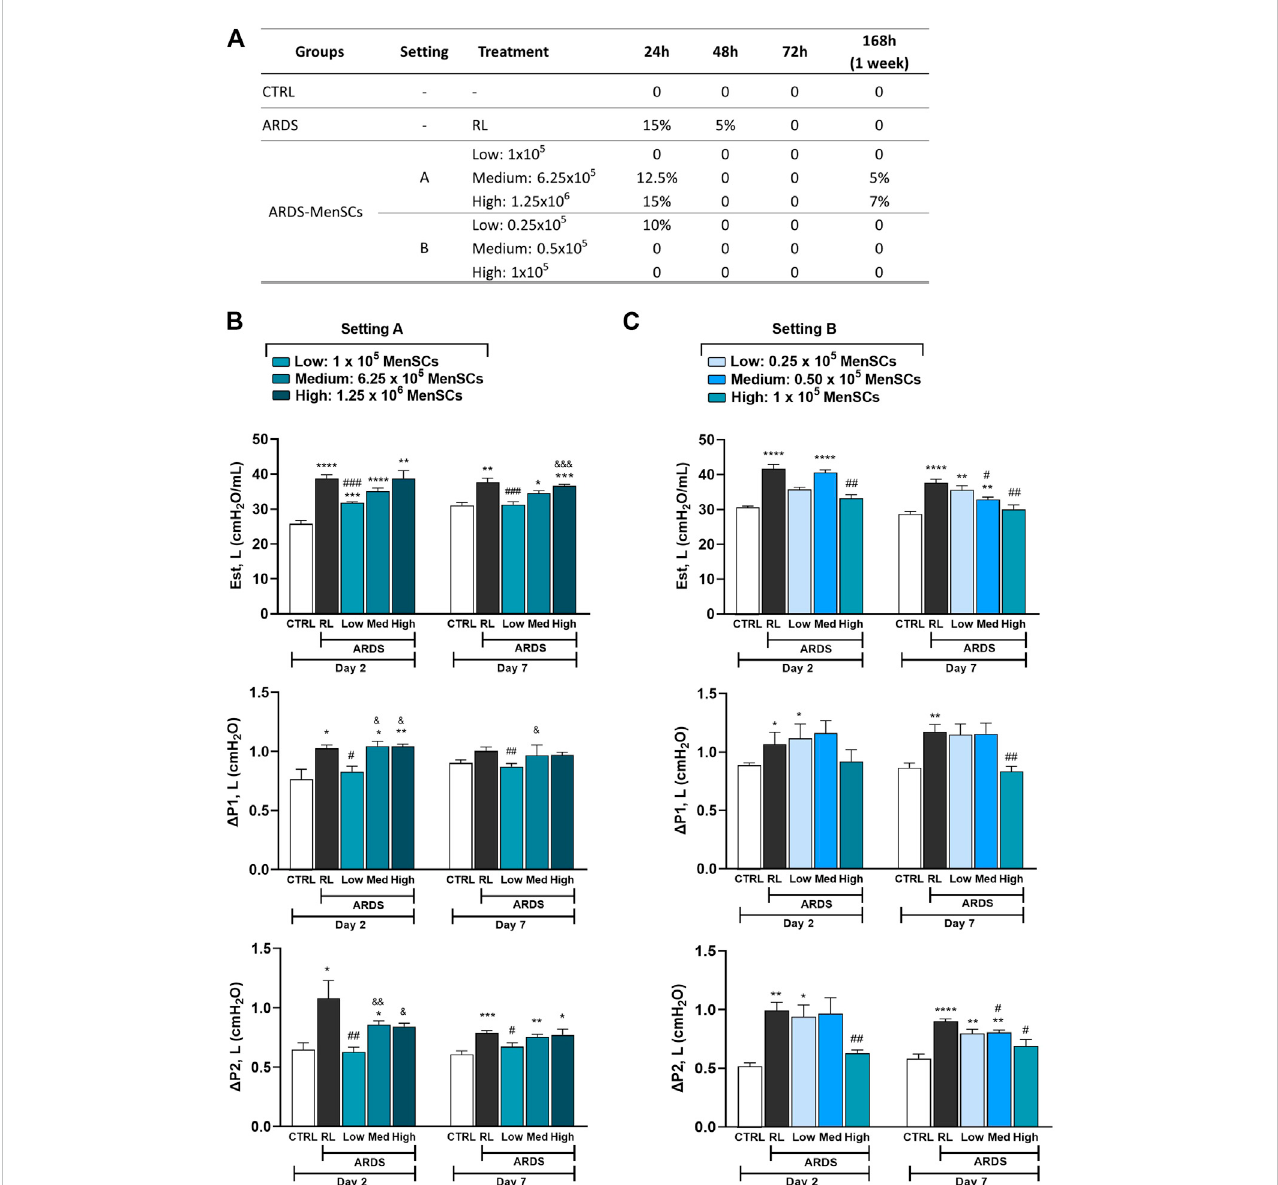
FIGURE 4 Treatment with cryopreserved MenSCs improves themortality rate andlung mechanics after inductionofARDS.Animalswere randomly assignedto the control (CTRL) group or the ARDS group and received Ringer ’ s lactate (RL) or Escherichia coli lipopolysaccharide (LPS), respectively. After 24 h (day 1), the animals with ARDS were randomly divided into those that were treated intravenously with RL (ARDS RL group) or with cryo-MenSCs (ARDS MenSCs group) at different doses according to each setting, A or B (n = 8 – 10 animals/group). (A) Mortality rate for the ARDS mouse model with cryo-MenSCs at different treatment regimes. (B , C) Effect of MenSCs on lung mechanics. The evaluation of static lung elastance (Est, L), resistive ( Δ P1), and viscoelastic ( Δ P2)